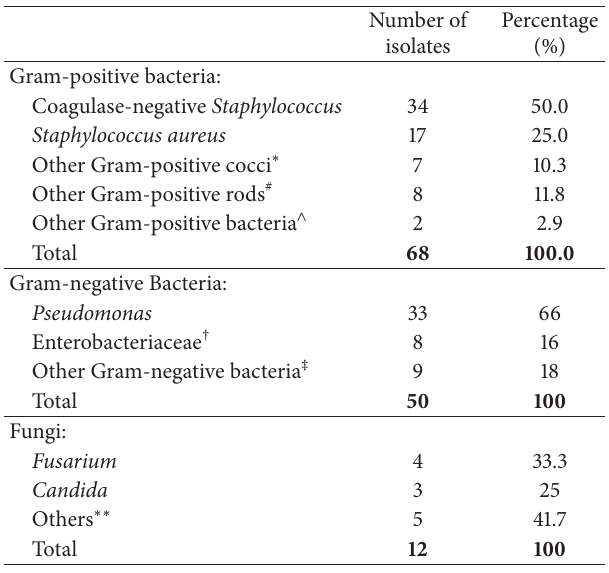
Table 2: Distribution of microbial isolates.